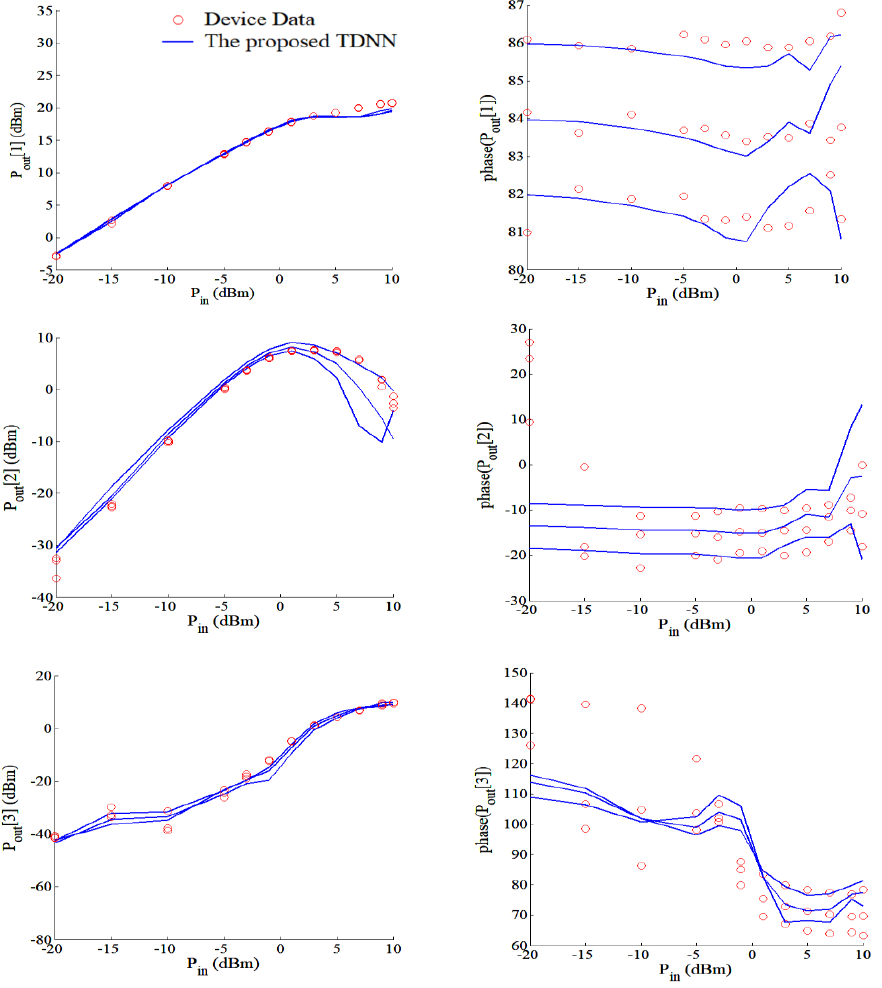
Figure 7. Comparison of magnitude and phase responses of the proposed TDNN model and device data at fundamental frequency 2.5 GHz, 3.5 GHz, and 4.5 GHz. Each blue line represents the magnitude or phase of output power along the input power at different fundamental frequencies.